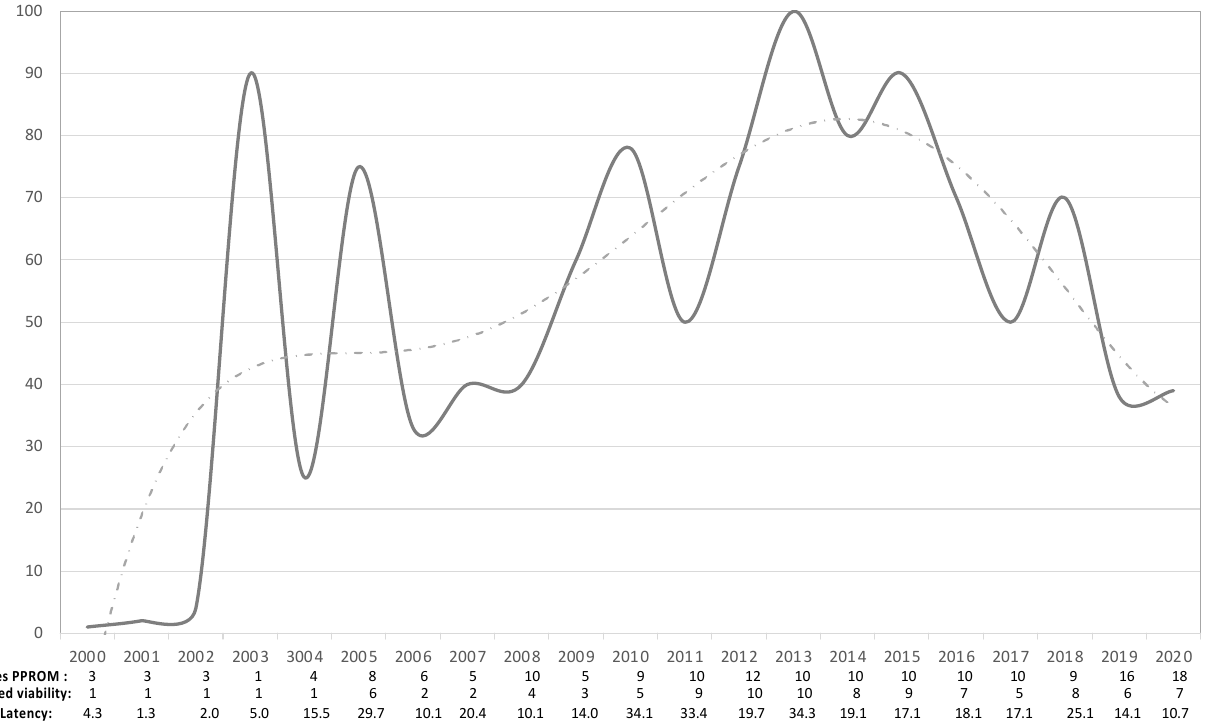
Figure 6. Rate of cases with pre-viable PPROM that reaches viability (gestational age 24 weeks). Considering the overall sample of pre-viable PPROM ( n = 169), at the moment of diagnosis and admission to the hospital the chance to deliver at 28 weeks g.a. was 13.7%. After seven uneventful days following the diagnosis, the probability to deliver at 26 or 28 weeks of g.a. was 54.5%, or 45.9%, respectively, and 76.4% or 62.3% after 14 days of latency (ROC curves at Figure 7).